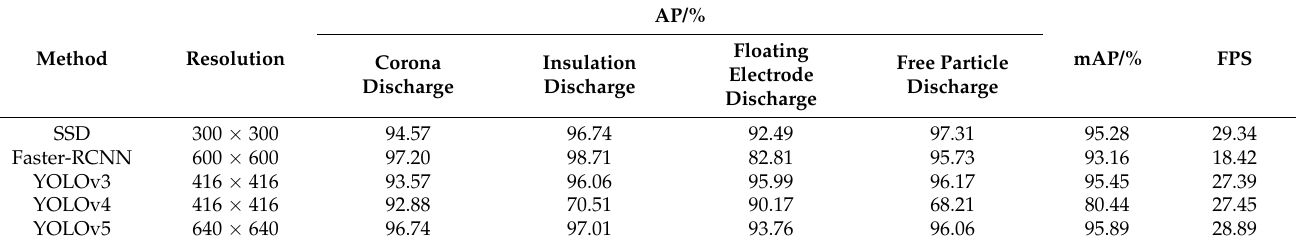
Table 5. Detection results of different